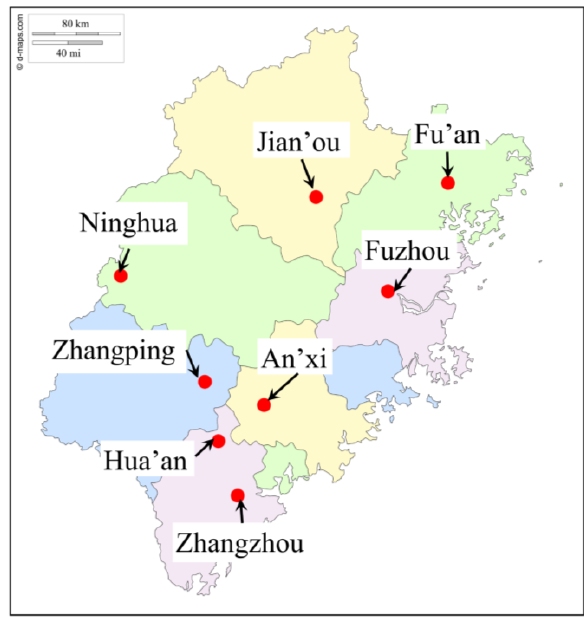
Figure 2. Map of eight cities in Fujian.